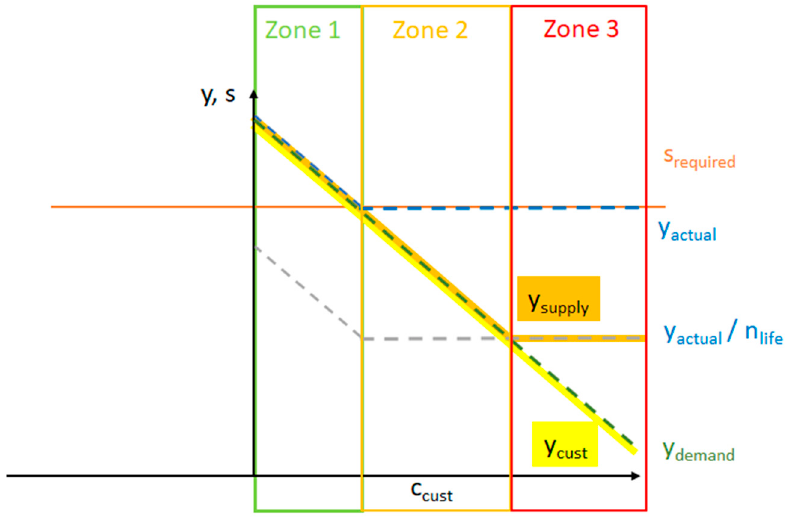
Figure A2. Theoretical relationships between price and amount variables.